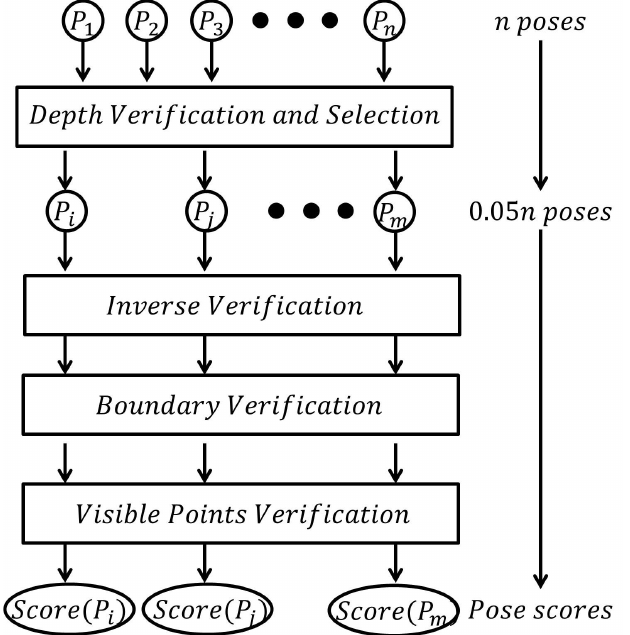
Figure 8. The pipeline of pose